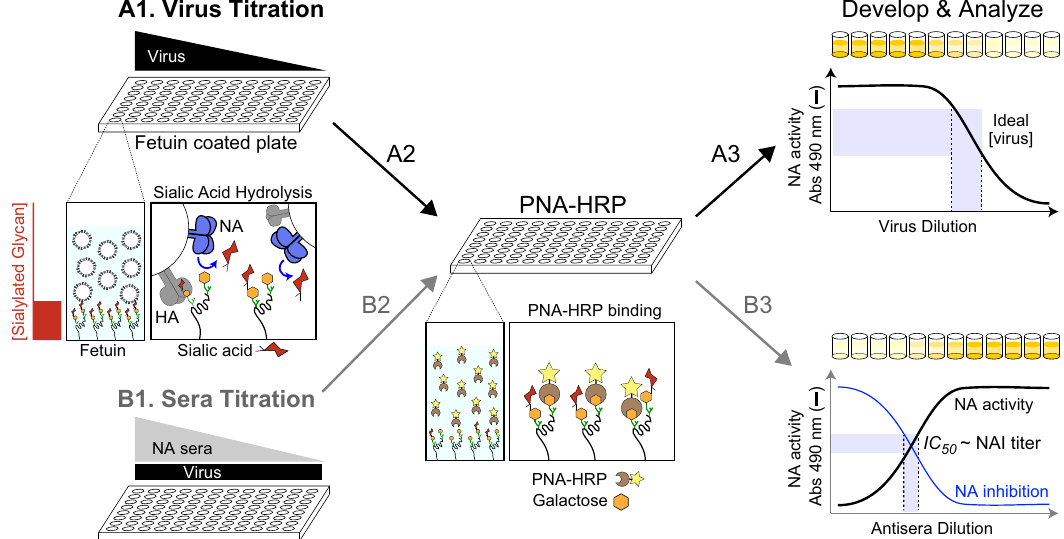
Fig. 1 Illustration of the enzyme-linked lectin assay (ELLA) for comparing NA antigenicity. Step A1, viruses are titrated using fetuin-coated plates. Step A2, NA exposed galactose residues on the fetuin glycans are bound by peanut agglutinin linked to horseradish peroxidase (PNA- HRP). Step A3, PNA-HRP binding is determined using the substrate OPD and measuring the absorbance (Abs) at 490 nm. Step B1, Ferret antisera are titrated with a fi xed virus dilution from the linear range and added to fetuin-coated plates and processed similarly for PNA-HRP binding (Step B2) and development (Step B3). NA inhibition (NAI) titres are determined by inversely plotting the NA activity data and calculating the reciprocal sera dilution that corresponds to the 50% inhibitory concentration ( IC 50